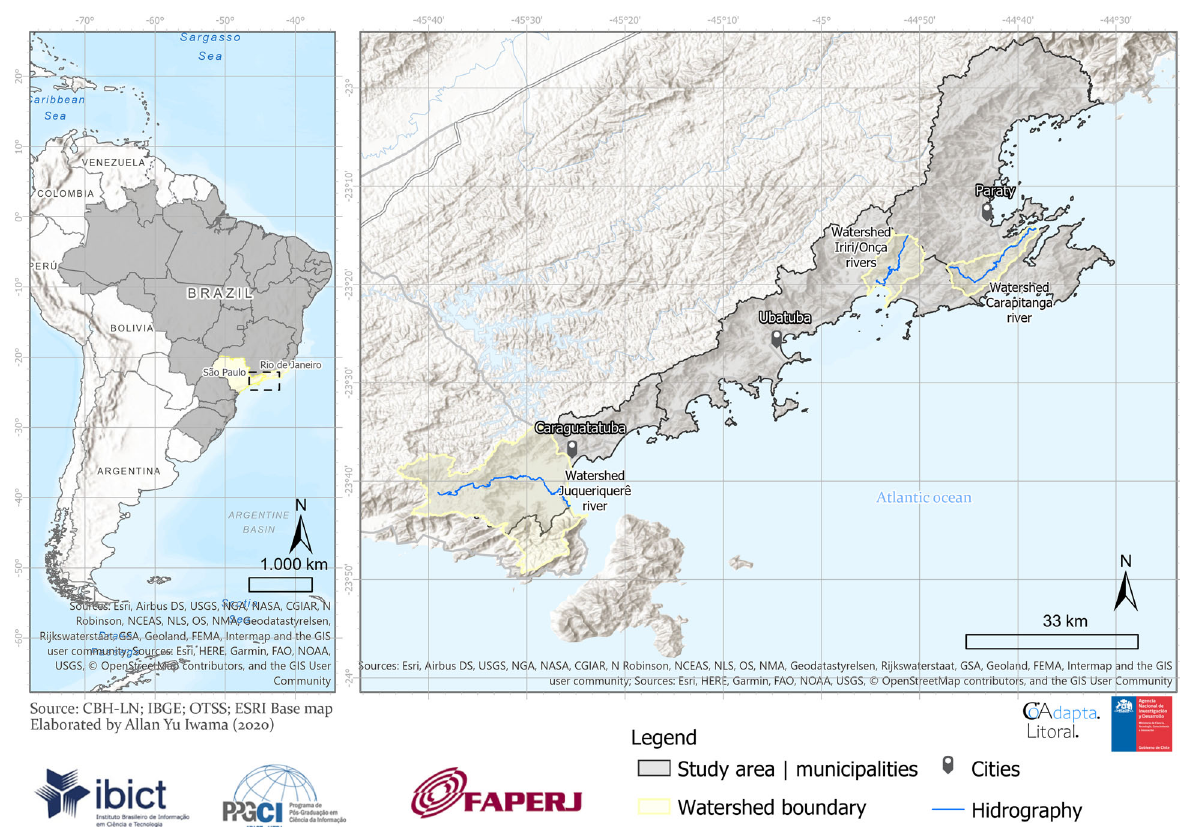
Fig. 1 Study area: Caraguatatuba and Ubatuba, in the state of Sao Paulo (the Juqueriquere river basin and Iriri/Onça river basin, respectively). Paraty, in the state of Rio de Janeiro (the river basin Carapitanga). Source: Digital maps from CBH-LN; IBGE; OTSS; ESRI base